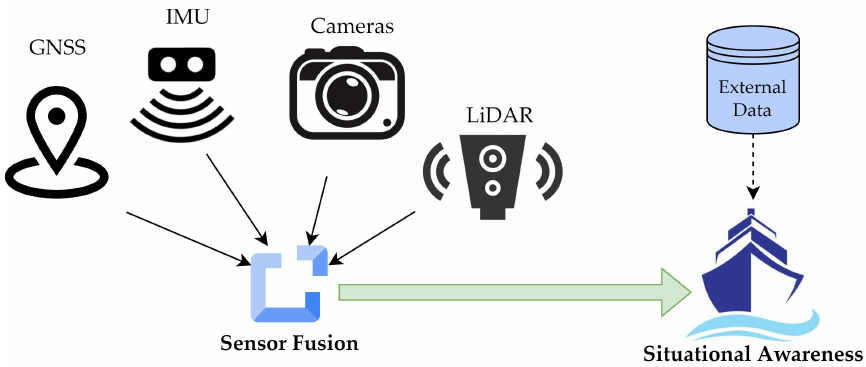
Figure 2. High-level Overview of the physical layer. The sensors provide information about the environment to incorporate situational awareness in the